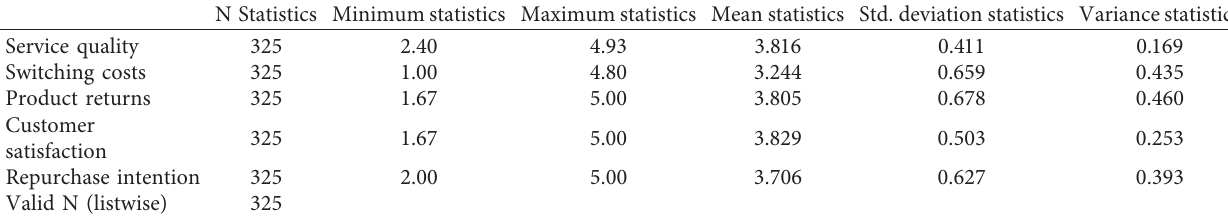
Table 3: Descriptive statistics of the study.